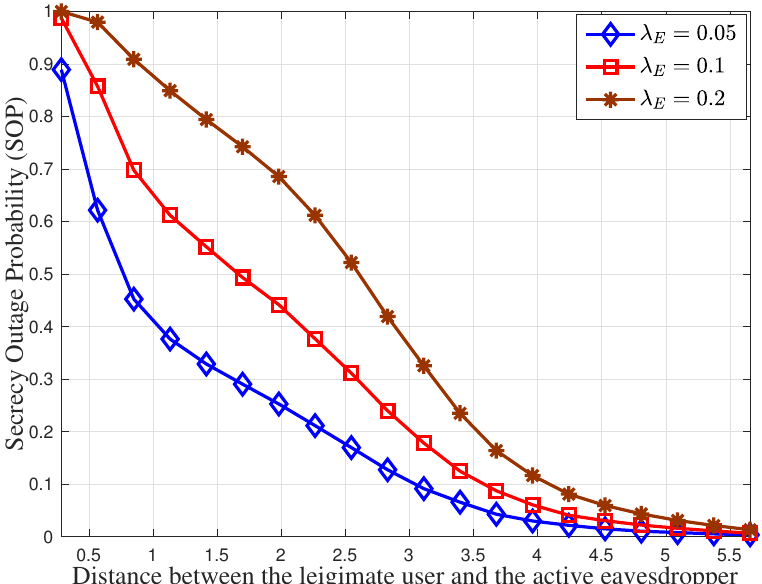
Figure 2. Secure outage probability (SOP) plotted as a function of distance between legitimate user and active eavesdropper for different densities ( λ E ) of passive